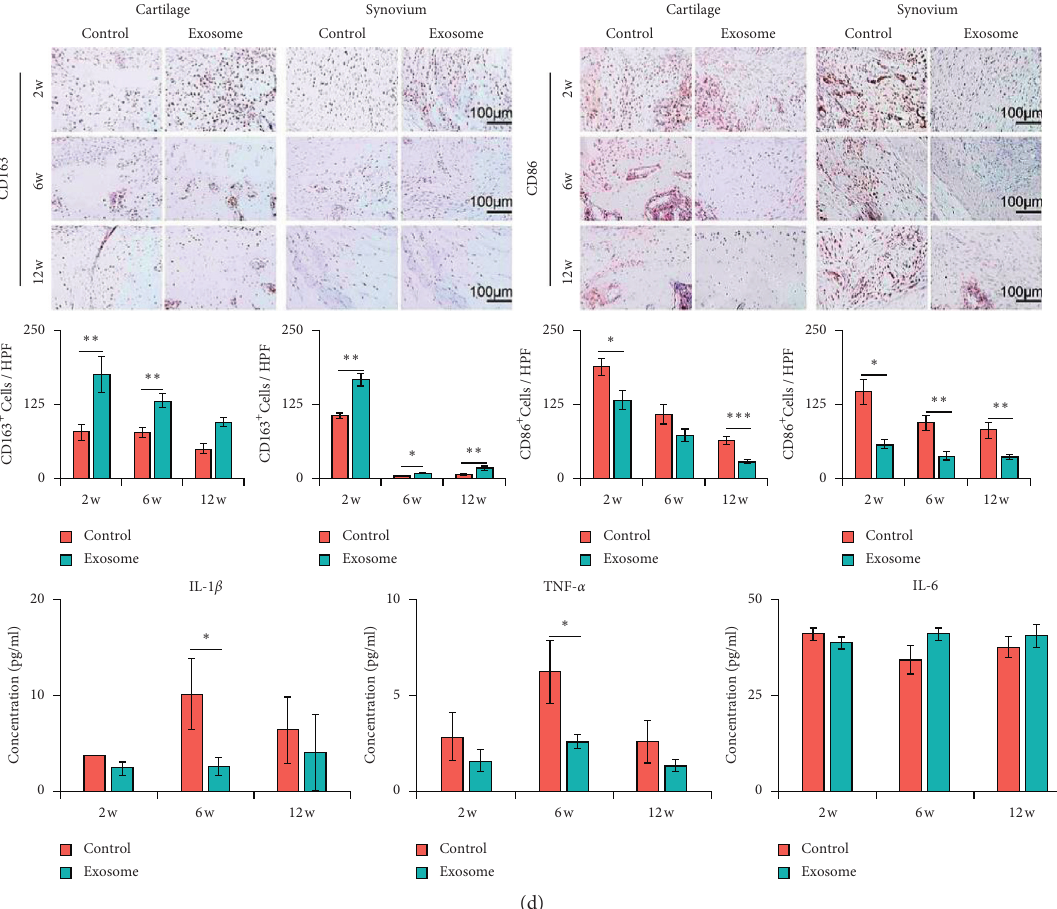
Figure 2: (a) The schematic diagram indicating the crosstalk between MSCs and macrophages. (b) The relative gene expression of Runx2 and ALP in MSCs. Gene expression of Runx2 and ALP in hMSCs after culturing in unconditioned control media (Ctrl) or monocyte conditioned media (CM) for 72 h [88] (Copyright 2011, Elsevier). (c) Proliferation and ALP activity of MSCs indirectly cocultured with M0, M1, and M2 macrophages [90] (Copyright 2017, Springer). (d) Effects of MSC exosomes on macrophage infiltration and proinflammatory cytokine production during cartilage repair [101] (Copyright 2018,